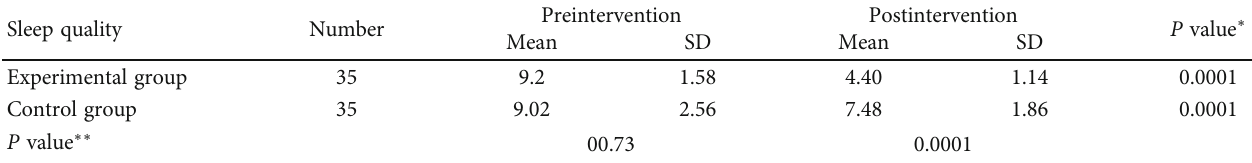
Table 2: Comparison of mean scores of SQ of participants in the experimental and control